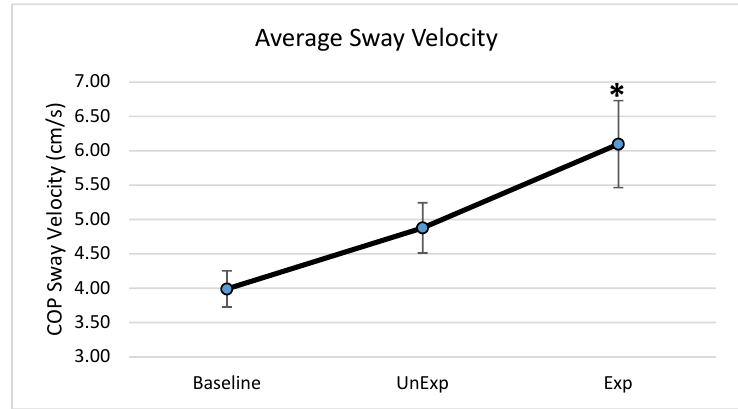
Figure 7. Center of pressure average sway velocity (cm / s) during baseline, unexpected (UnExp) moving wall, and expected (Exp) moving wall conditions. Bars represent standard errors. * Represents a significant di ff erence at p < 0.05 compared to the baseline